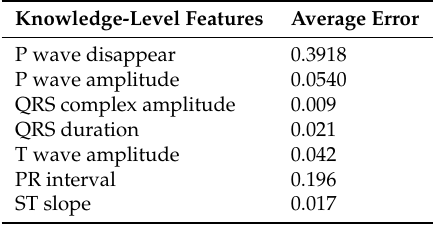
Table 3. Error analysis of knowledge-level features on the Atrial Fibrillation Monitoring